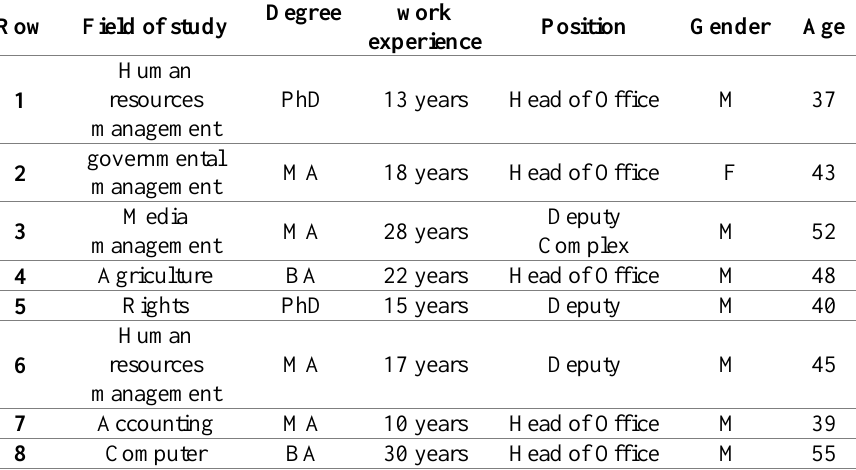
Table 1. Demographic characteristics of the